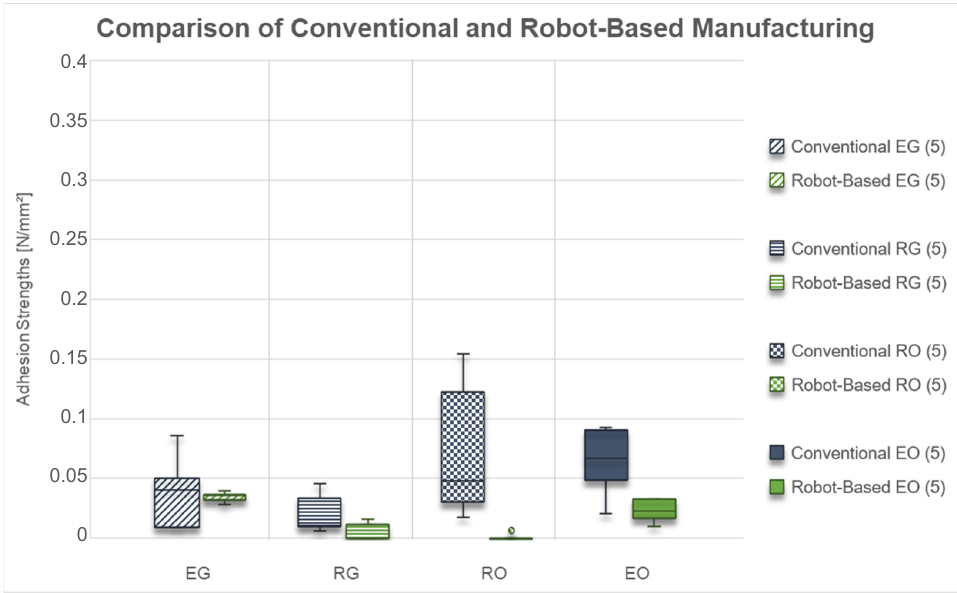
Figure 6. Box Plots of adhesion strengths achieved by conventional and robotic fused filament fabrication on silicone build plates (included number of samples).